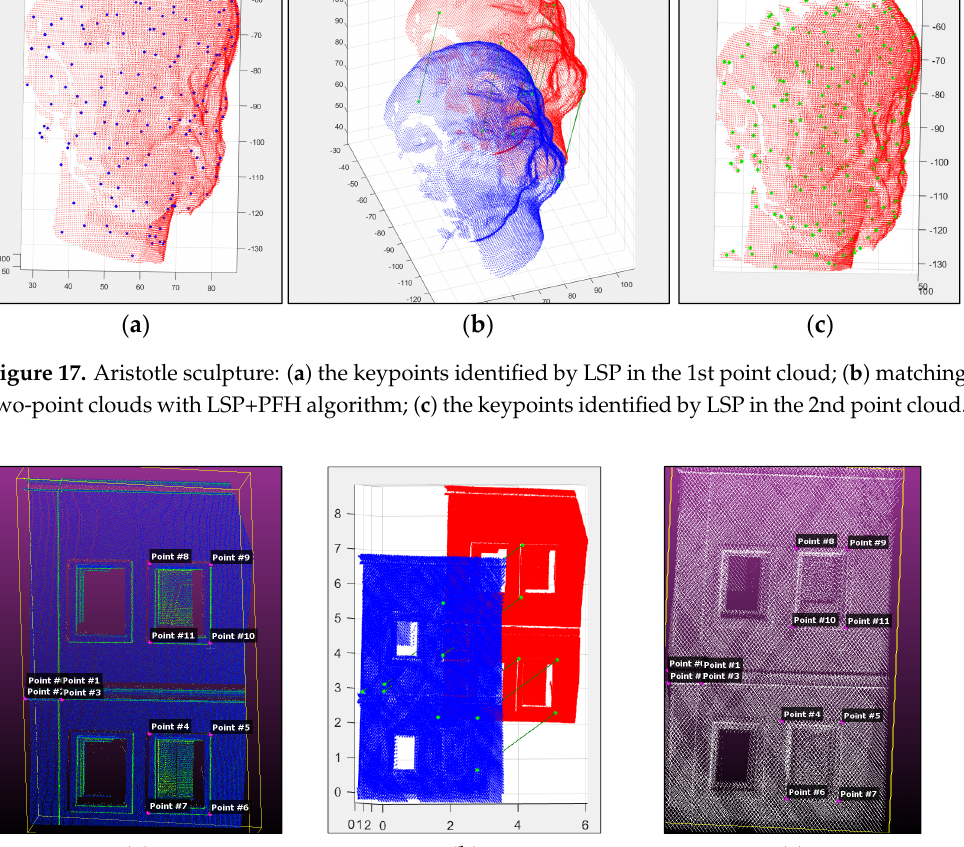
Figure 18. Building facade: ( a ) the keypoints identified by the new detector in the TLS point cloud; ( b ) matching TLS and MLS point clouds using semi-automatic evaluation of the new algorithm; ( c ) the keypoints identified by the new detector in the MLS point cloud data.